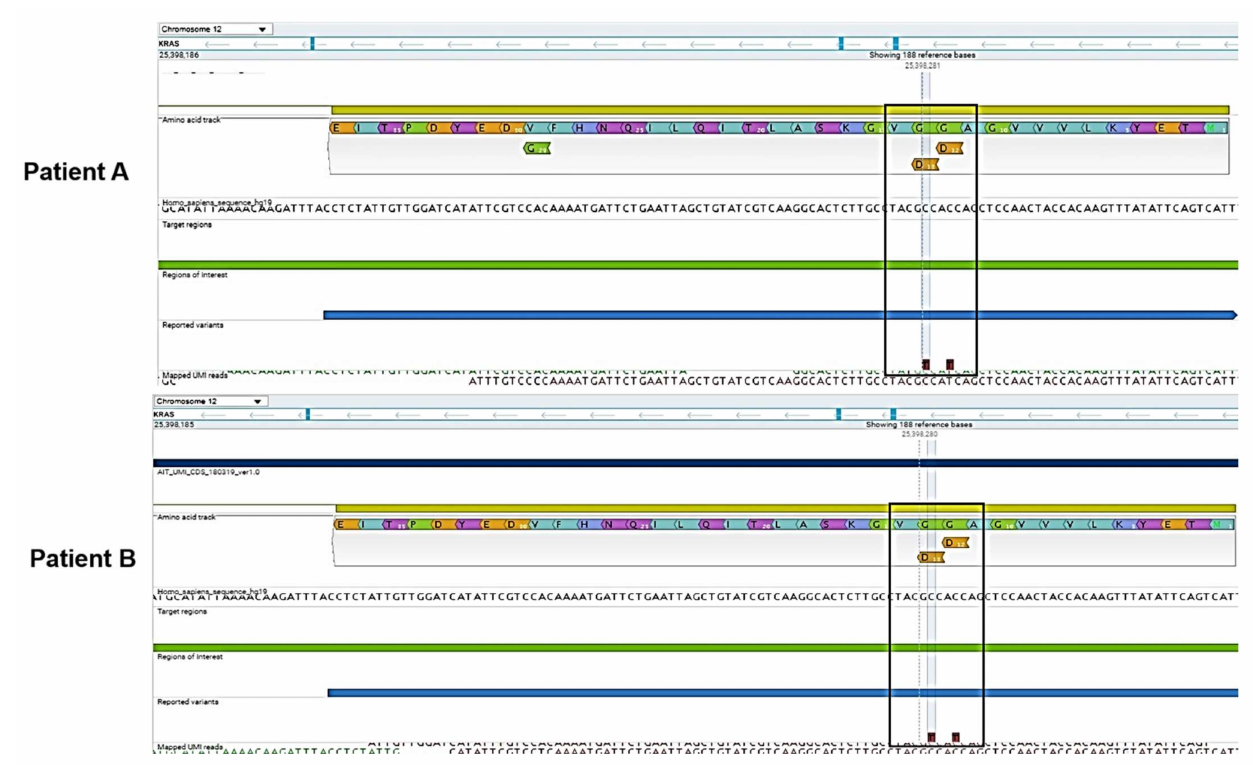
Figure 1. Next generation sequencing analysis of Patient A and B displaying in the exon 2 of the KRAS gene the double nu- cleotide changes c.38G>A (amino acid change p.G13D) and c.35G>A (amino acid change p.G12D) of pathogenic significance. The black box highlights both